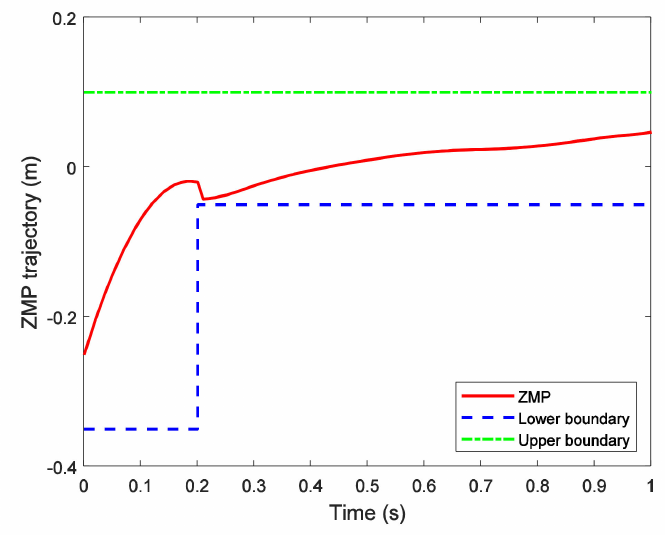
Figure 8. Trajectory of ZMP.